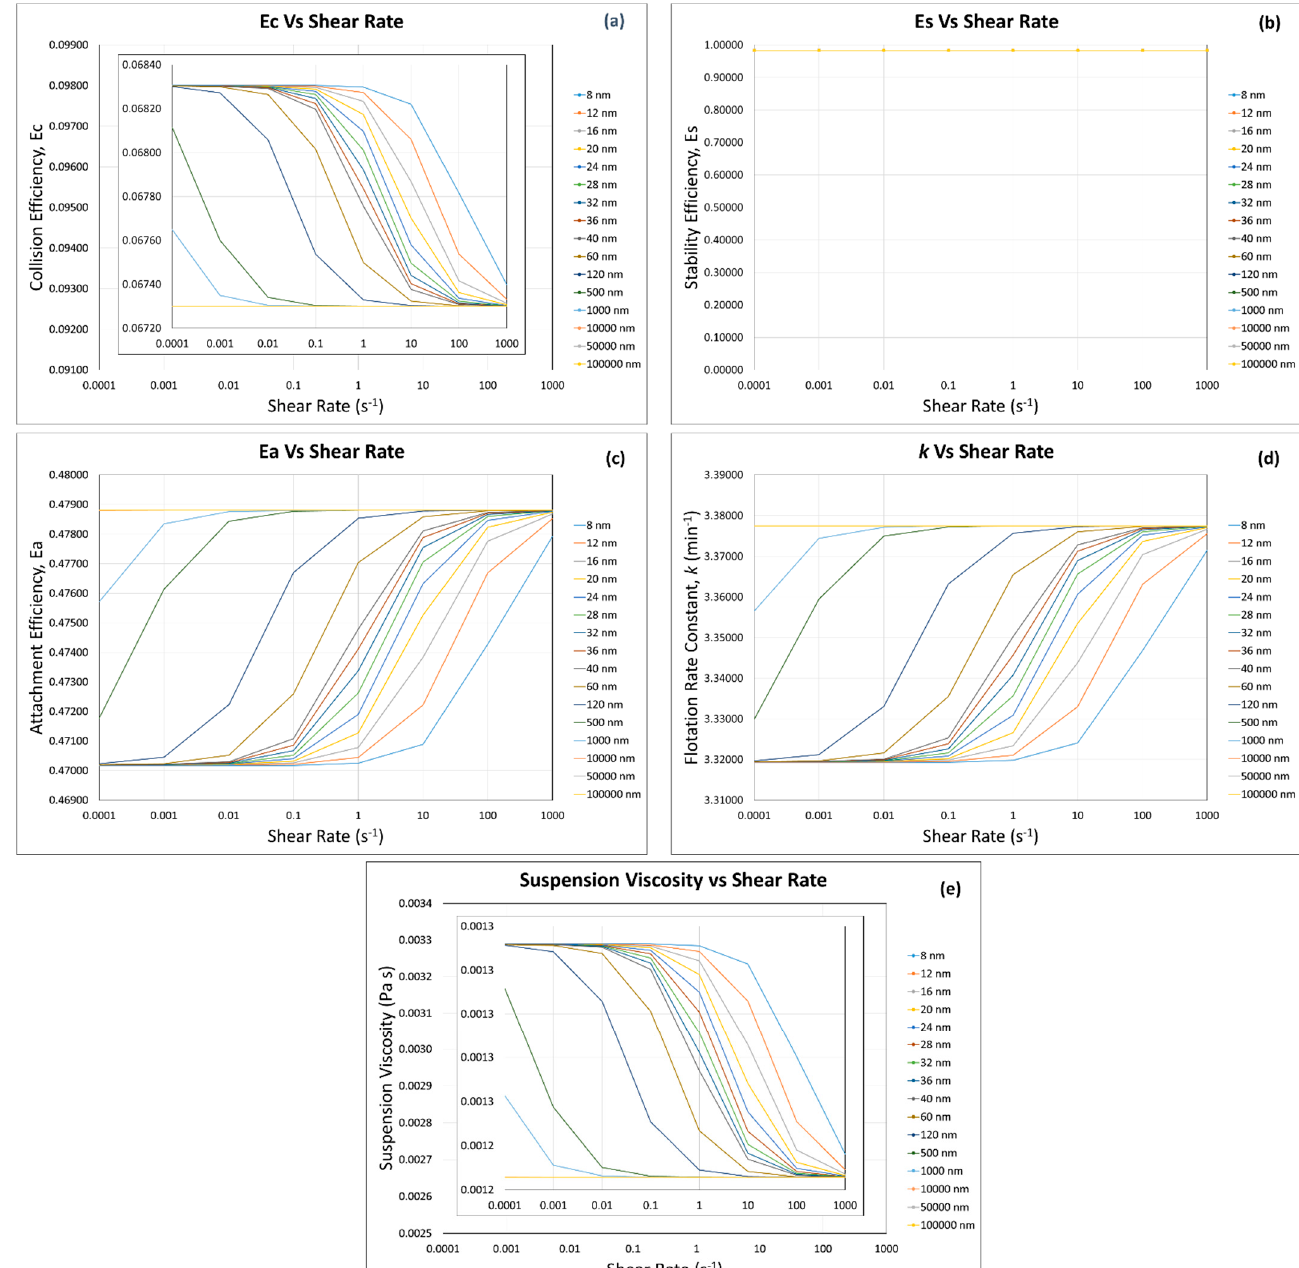
Figure 9. Flotation efficiencies: ( a ) collision, ( b ) stability, ( c ) attachment, and ( d ) rate constant by using ( e ) the suspension viscosity calculated by the predictive model (same quartz particles with same sizes) at 𝜙 = 0.1 . Note: the major y-axes of subfigures ( a , e ) are made for the purpose of comparison.